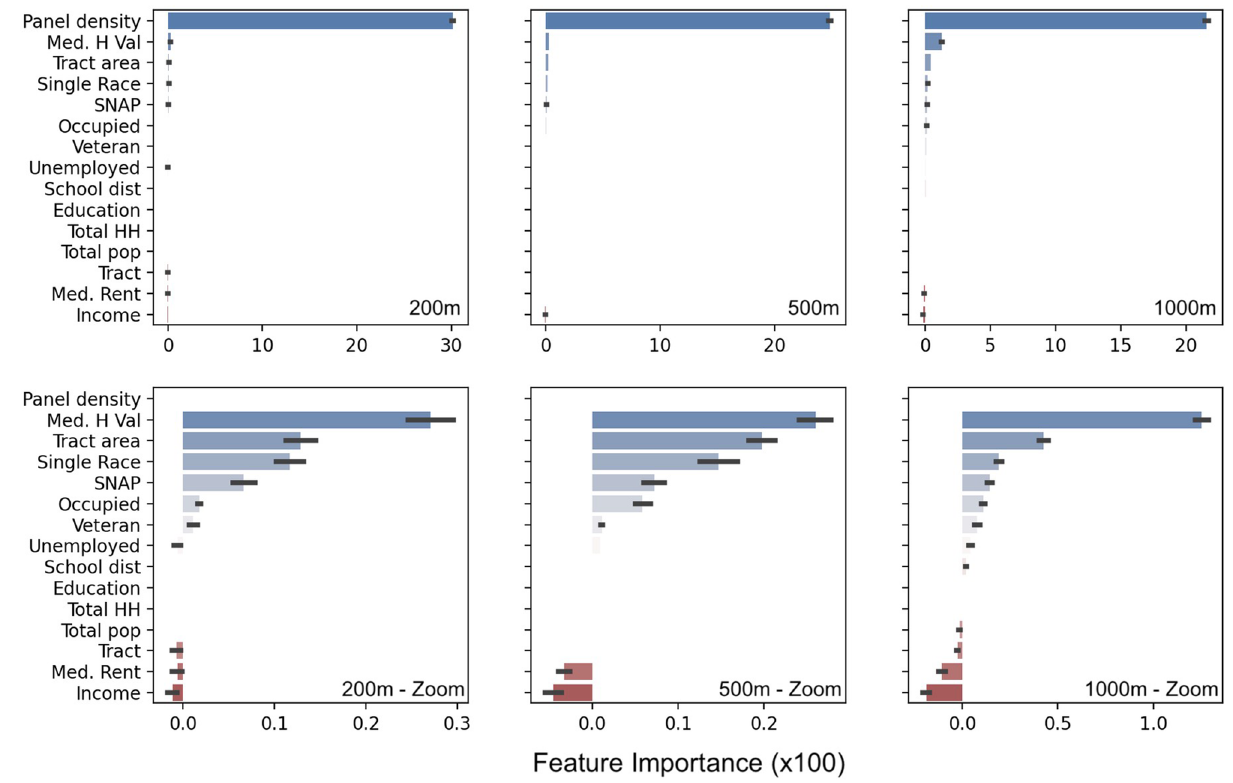
Figure 2. Panel density most important feature for predicting solar panel installation . Feature importance scores by variable are shown as point value of performance contributed by each feature for all features, multiplied by 100. The solar panel densities shown are calculated at 200 m, 500 m, and 1 km around each address in the dataset (see Supplementary Table S5 for results for all 100 m increments between 200 m and 1200 m). The top panel shows the bar plot of all features in the model, the lower panel shows a zoomed view of all features excluding the density feature for each model. Across all models, panel density consistently contributes the largest gains in performance. Feature importance is highest for a radius of 200 m and decreases with radius